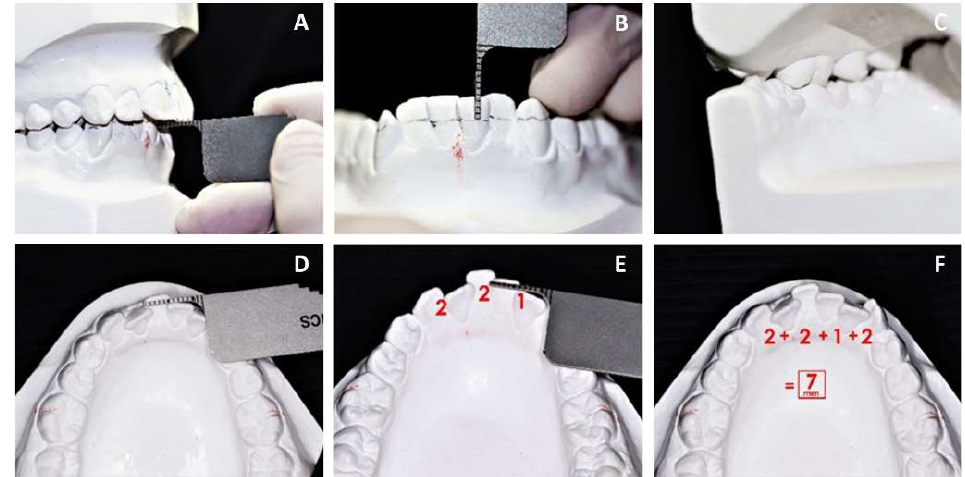
Figure 3. ( A , B ) Manual overjet and overbite measurement. ( C ) Posterior view of buccal posterior crossbite for manual measurement. ( D – F ) Manual measurement of crowding.